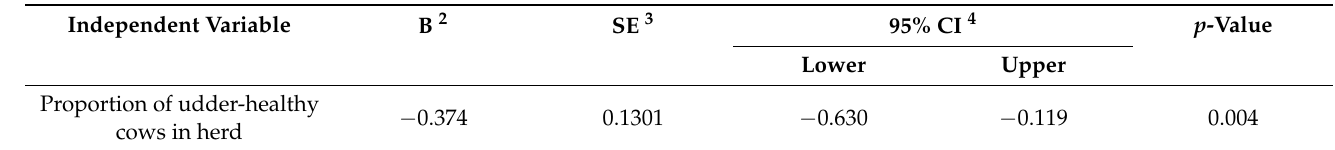
Table 3. Generalized linear model describing pre-partum risk factors (independent variable) associ- ated with HMR1 (dependent variable).